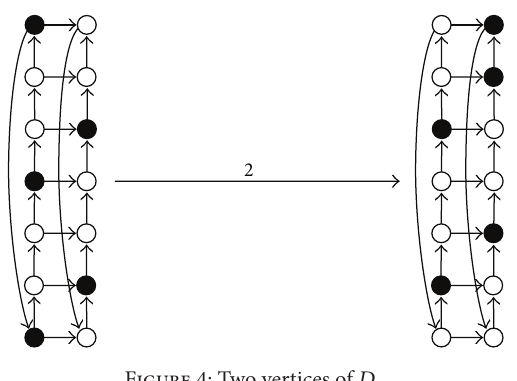
Figure 4: Two vertices of 𝐷 7